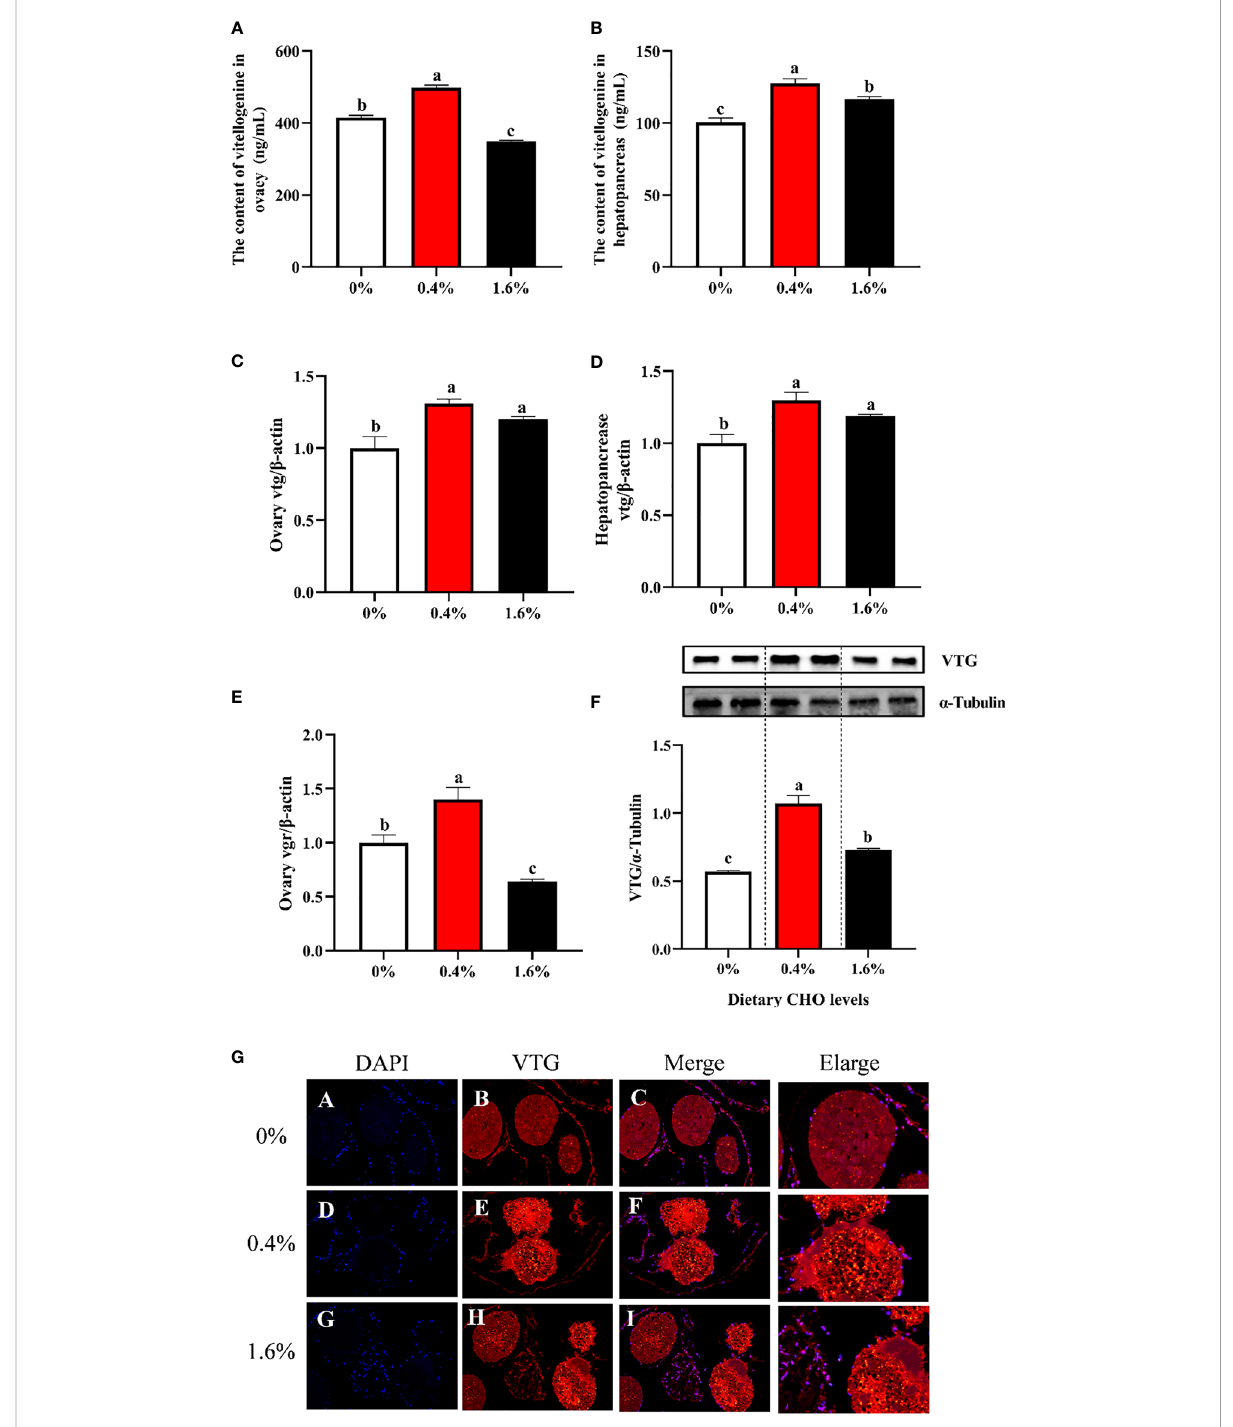
FIGURE 3 Effects of dietary CHO on (A) the content of Vtg in ovary; (B) the content of Vtg in hepatopancreas; (C) the mRNA expression of vtg in ovary; (D) the mRNA expression of vtg in hepatopancreas; (E) the mRNA expression of vgr in ovary; (F) the protein expression of VTG in ovary. (G) the immuno fl uorescence of VTG in ovarian tissue of E.sinensis after fed with diets supplemented different CHO levels (blue: nucleus; red: VTG). The values are the Means ± SEM ( n = 4). Different letters indicate signi fi cant differences ( P <